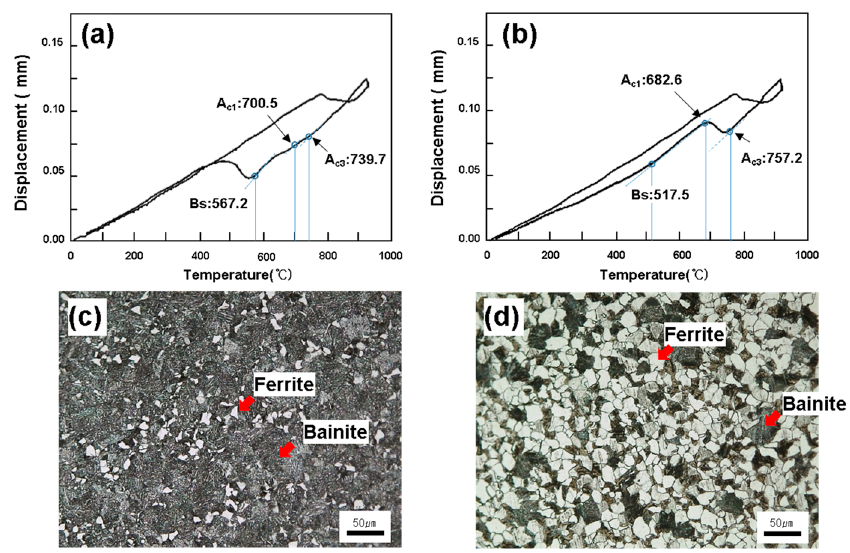
Figure 1. Micrographs showing the morphology of model A steel: ( a ) experimental dilatometer curve of simulated surface cooling rate (200 °C/min at 930 °C) in the 300 mm thick wall steel; ( b ) experimental dilatometer curve of simulated center cooling rate (20 °C/min at 930 °C) in the 300 mm thick wall steel; ( c ) optical microscopy (OM) image of specimen cooled at 200 °C/min at 930 °C; ( d ) OM image of specimen cooled at 20 °C/min at 930 °C.